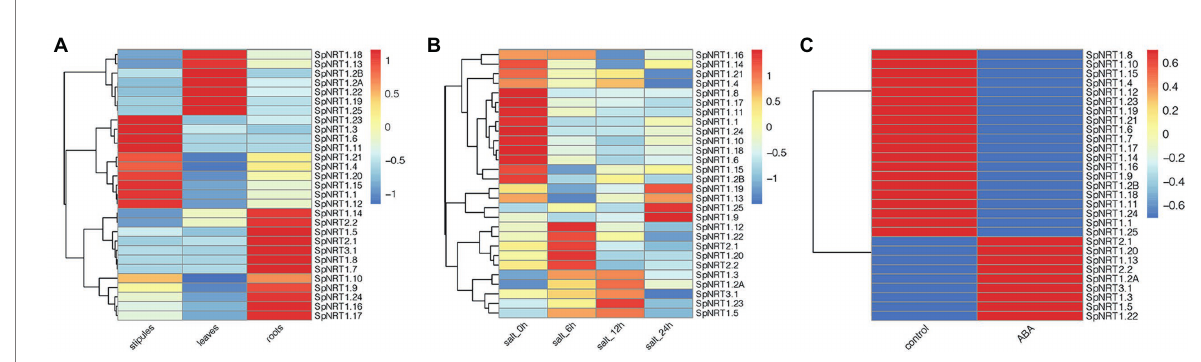
FIGURE 2 Expression patterns of SpNRT genes. (A) Relative expression level of SpNRT genes in various tissues determined by RNA-seq FPKM value. (B) Relative expression level of SpNRT genes response to salt stress determined by RNA-seq FPKM value. (C) Relative expression level of SpNRT gene response to ABA stress determined by RNA-seq FPKM value. Red means relative expression high and blue means lower. SpNRTs RNA-seq data downloaded from NCBI Sequence Read Archive (SRA) database were used to express profile analysis, all the data is listed